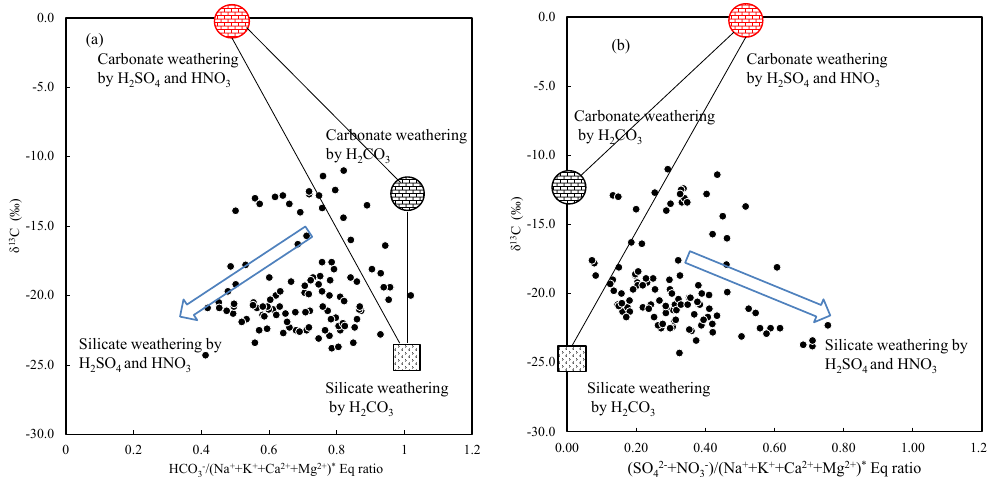
+ NO − )/( Na + + K + + Ca 2 + + Mg 2 + ) ∗ equivalent ratio in 4 3